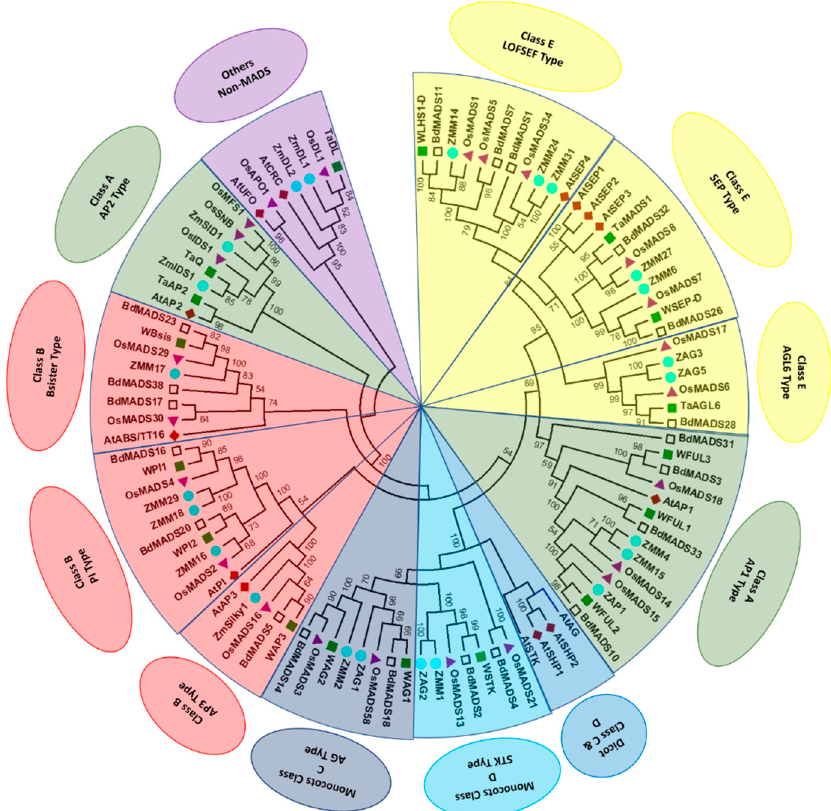
Figure 3. Evolutionary relationships among MADS-box genes. Phylogenetic tree constructed from the deduced amino acid sequences of Arabidopsis, Brachypodium, maize, rice, and wheat genes obtained from NCBI database. (Sequence ID information can be seen in supplementary file) The tree was inferred after amino acid sequence alignment by Clustal Omega [137], using the neighbor-joining method [138] and visualized in topology-only mode. Only bootstrap values >50%, as calculated from 100 replicates, are shown. Phylogenetic analysis was conducted in MEGA version 6 [139]. Markers: Diamond: Arabidopsis; triangle: rice; circle: maize; green filled square: wheat; hollow square: Brachypodium genes.